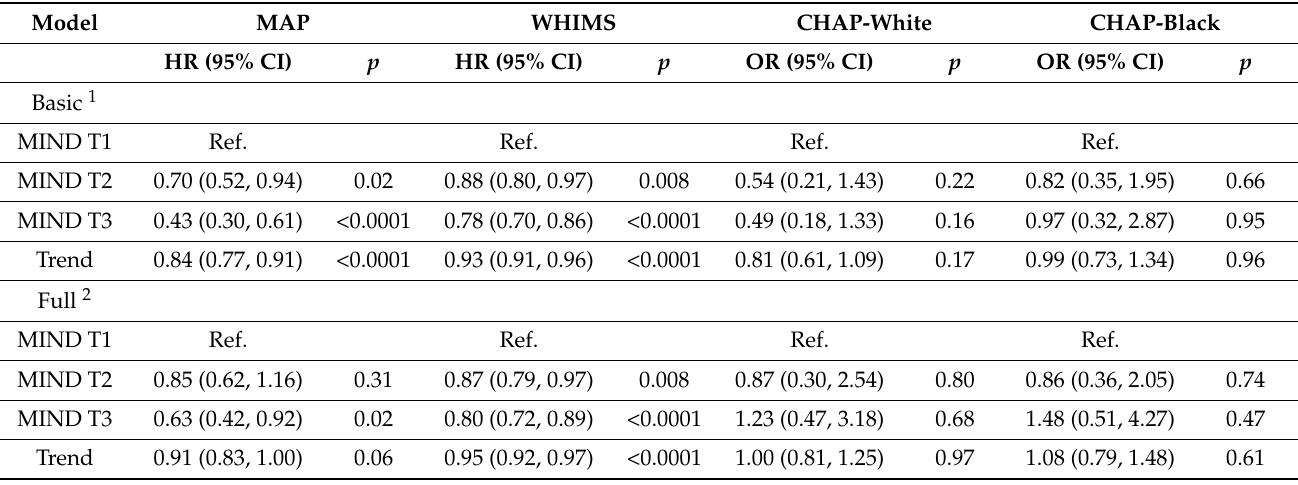
Table 2. MIND score and risk of all-cause dementia.